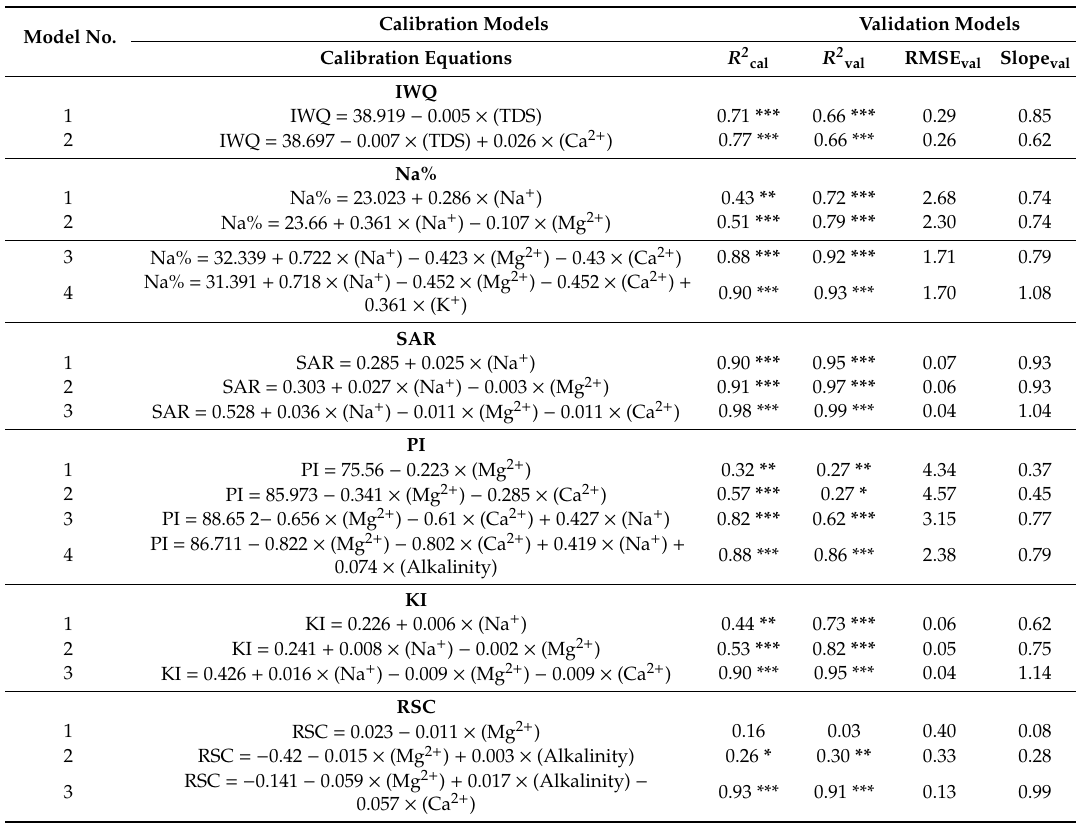
Table 7. Extraction the most influential physiochemical parameter to predict WQIs using the Stepwise Multiple Linear